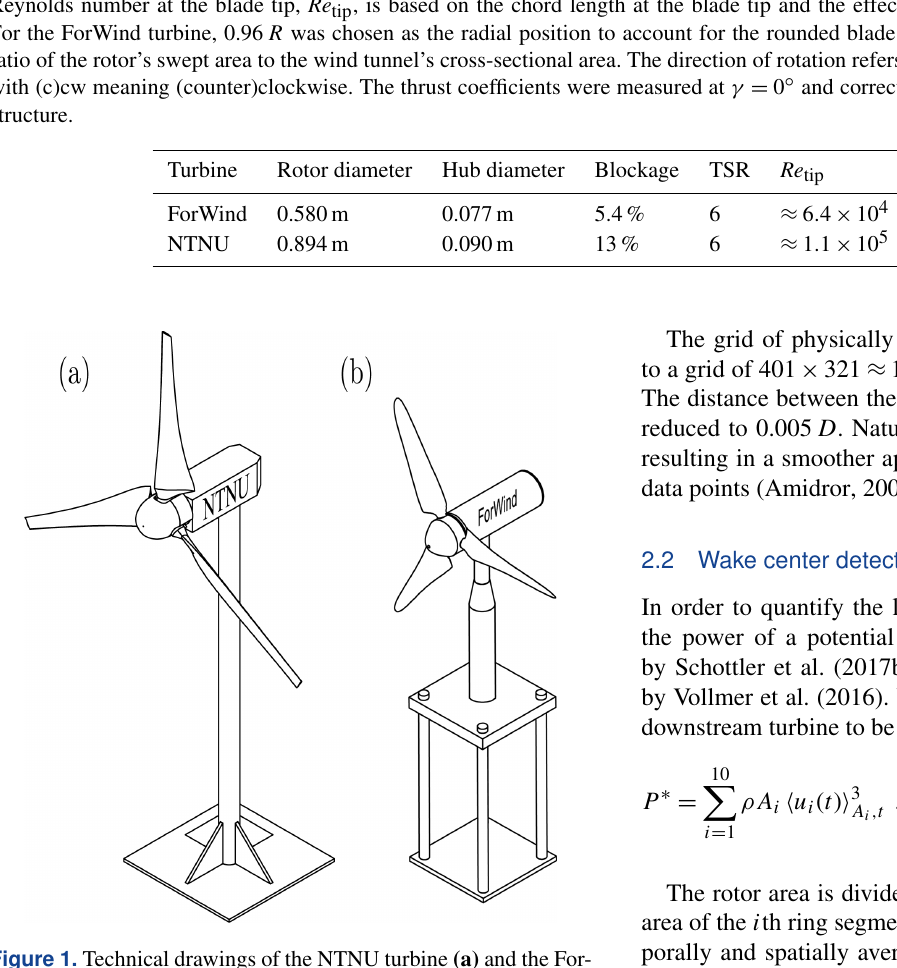
Figure 1. Technical drawings of the NTNU turbine (a) and the For- Wind turbine (b)